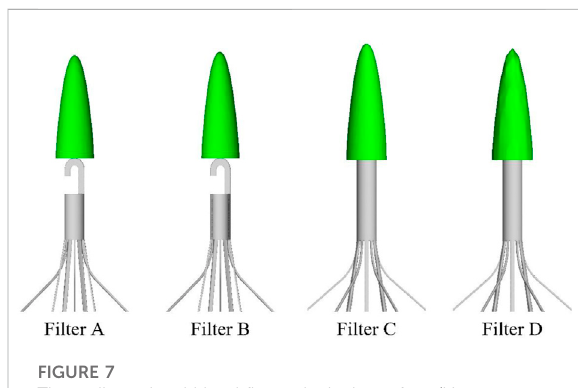
FIGURE 7 Three-dimensional blood fl ow velocity isosurface ( V = 0.8 V m = 0.056